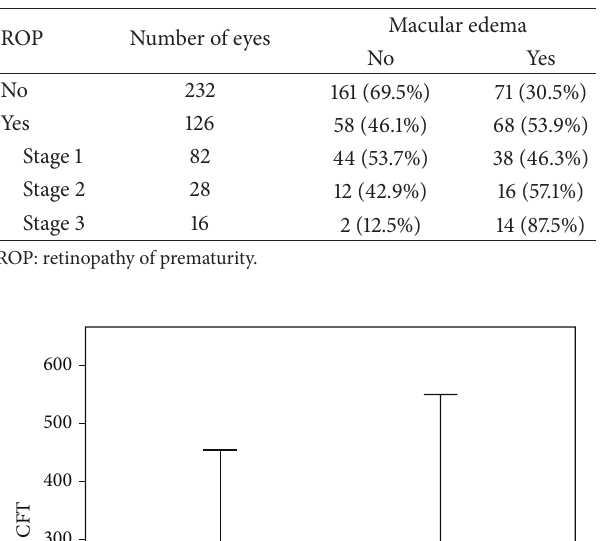
Table 2: Comparisons of macular edema between the eyes with and without ROP.